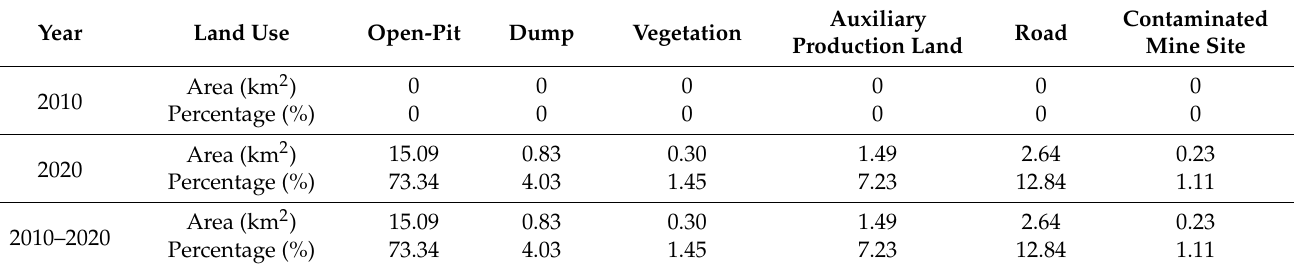
Table 3. Changes in the characteristic surface types of Sino Iron from 2010 to